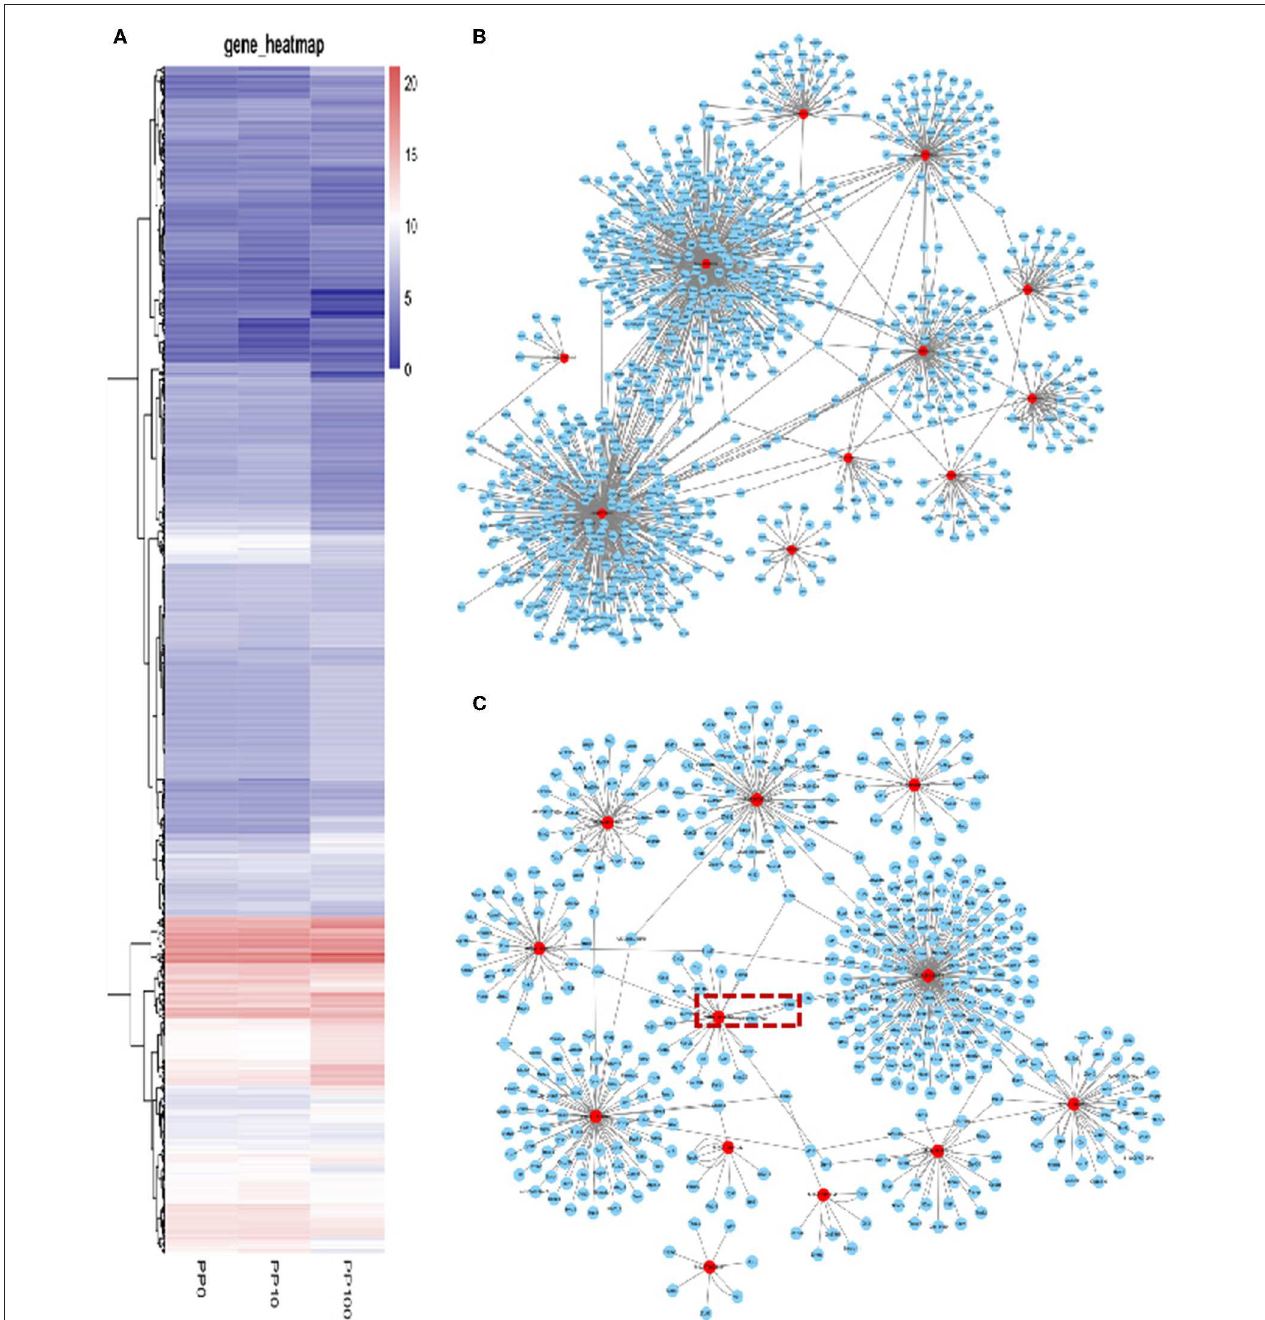
FIGURE 3 | DEHP Exposure Alters the miRNA Expression profile. (A) Heatmap shows the Euclidean distances between the samples calculated from the regularized log transformation; (B,C) predicted target genes of differentially expressed miRNAs.